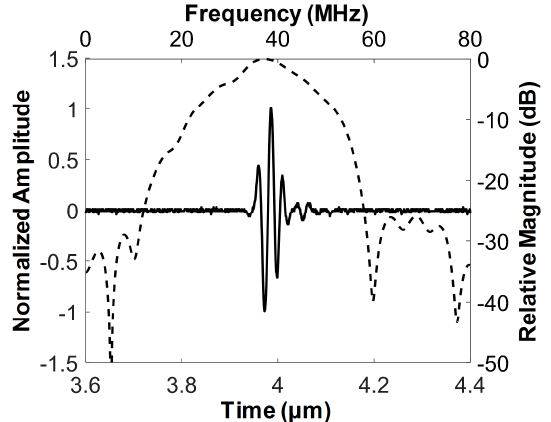
Figure 4. Measured pulse–echo response (solid line) and frequency spectrum (dashed line) of the developed FL–IVUS transducer.